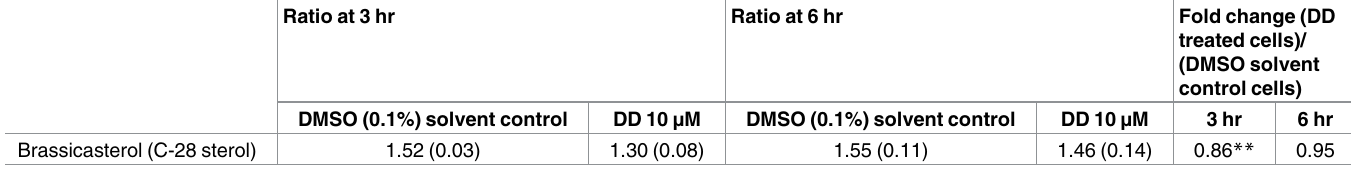
Table 6. Averagerelative ratio of brassicasterol in DMSO solvent and DD treated samples and fold changes in brassicasterol in 10 µ M DD treated cells compared to DMSO solvent control at 3 hr and 6 hr. Data represent averageof 5 biologicalreplicates for DD treatment and 4 biological replicates for DMSO solvent, values in bracket represents SD; ** p < 0.05determinedby student’s t-test comparedto solvent control.